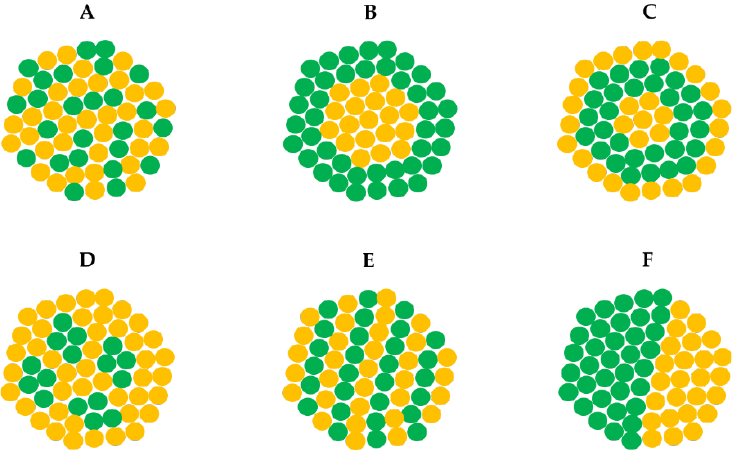
Figure 1. Different types of bimetallic nanoparticles: ( A ) alloyed, ( B ) core-shell, ( C ) multishell core- shell, ( D ) multiple core materials coated by a single shell, ( E ) intermetallic and ( F ) subclusters. The two types of metal atoms are marked in green and yellow. Modified from [25].